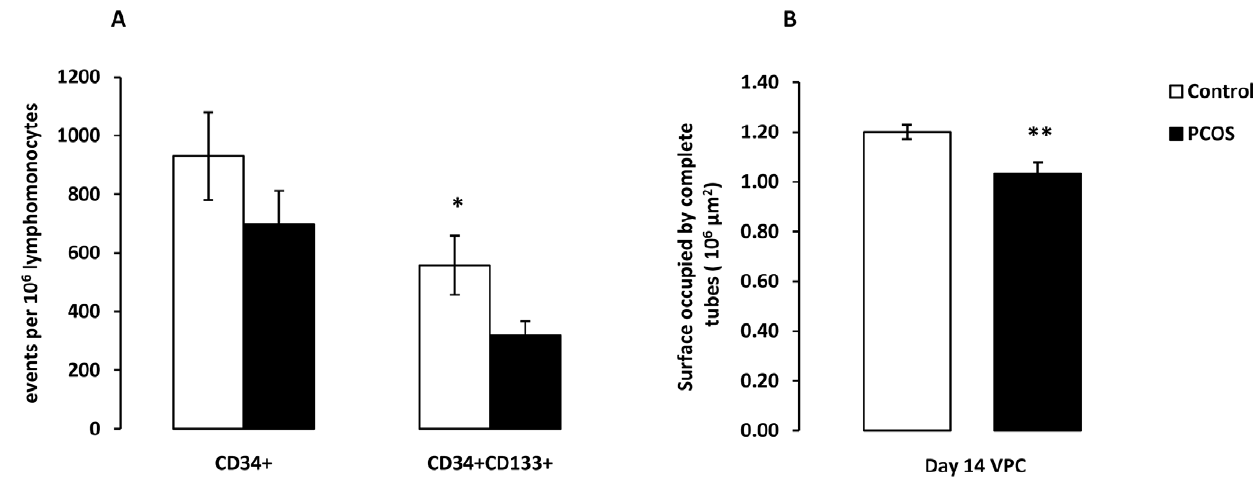
Figure 2. Tubule formation assay in healthy controls (A) and PCOS (B) patients. Panels A and B are representative pictures of the tubule network formed by the VPC (white dots) and HUVECs. The white line represents the surface area which was measured i.e. area formed by complete closed tubes.